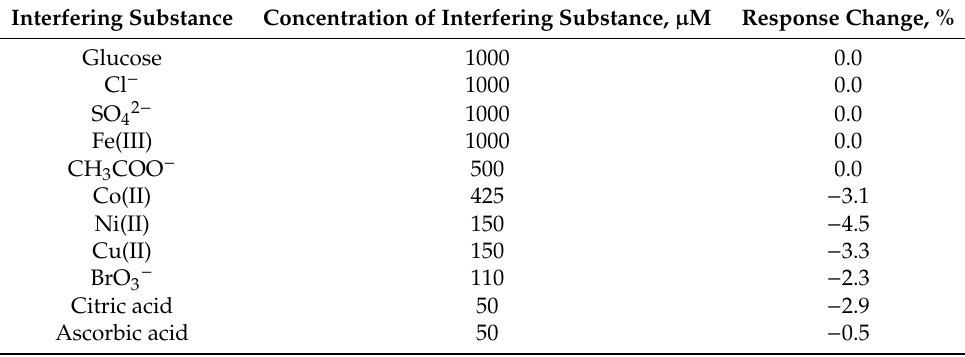
Table 1. Interfering e ff ect of various foreign species on nitrite response (nitrite response at C NO2 − = 5 µ M taken as 100%).